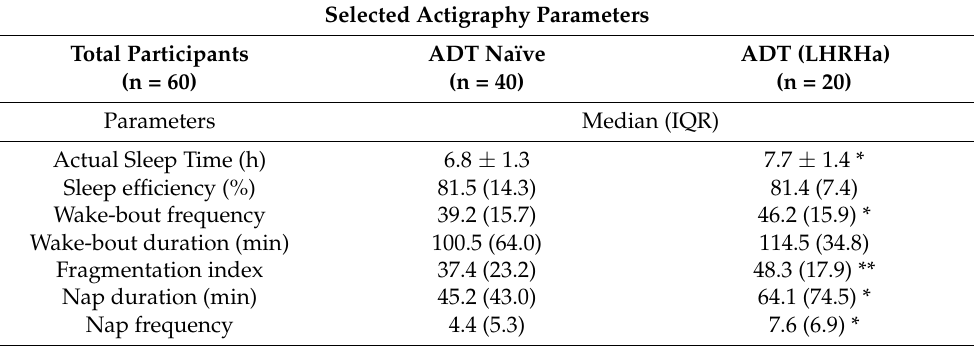
Table 4. Objective sleep characteristics of participants who were LHRH naïve versus those on ADT- LHRHa. Actigraphy data are presented as either mean ± standard deviation or median (interquartile range), depending on data normality.